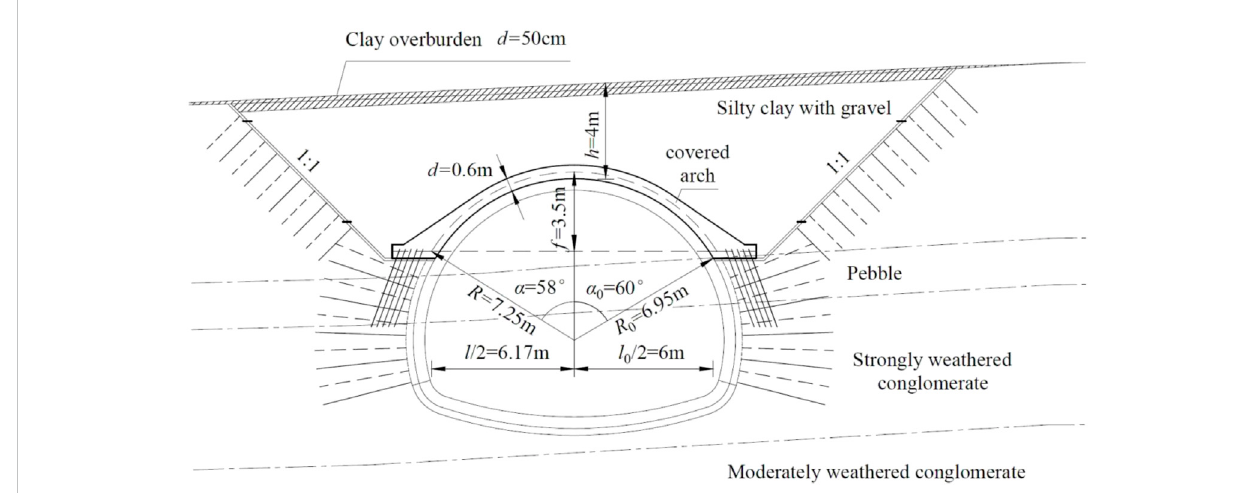
FIGURE 14 Typical design section of covered arch.